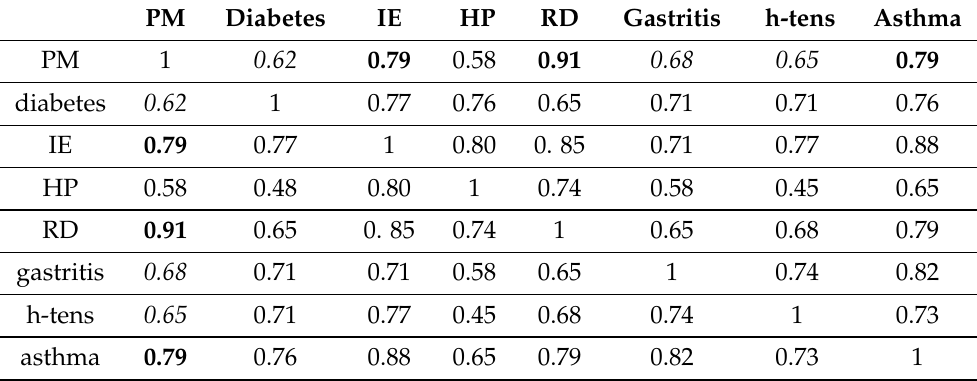
Table 4. ICrA results based on one month pollution exposure: µ